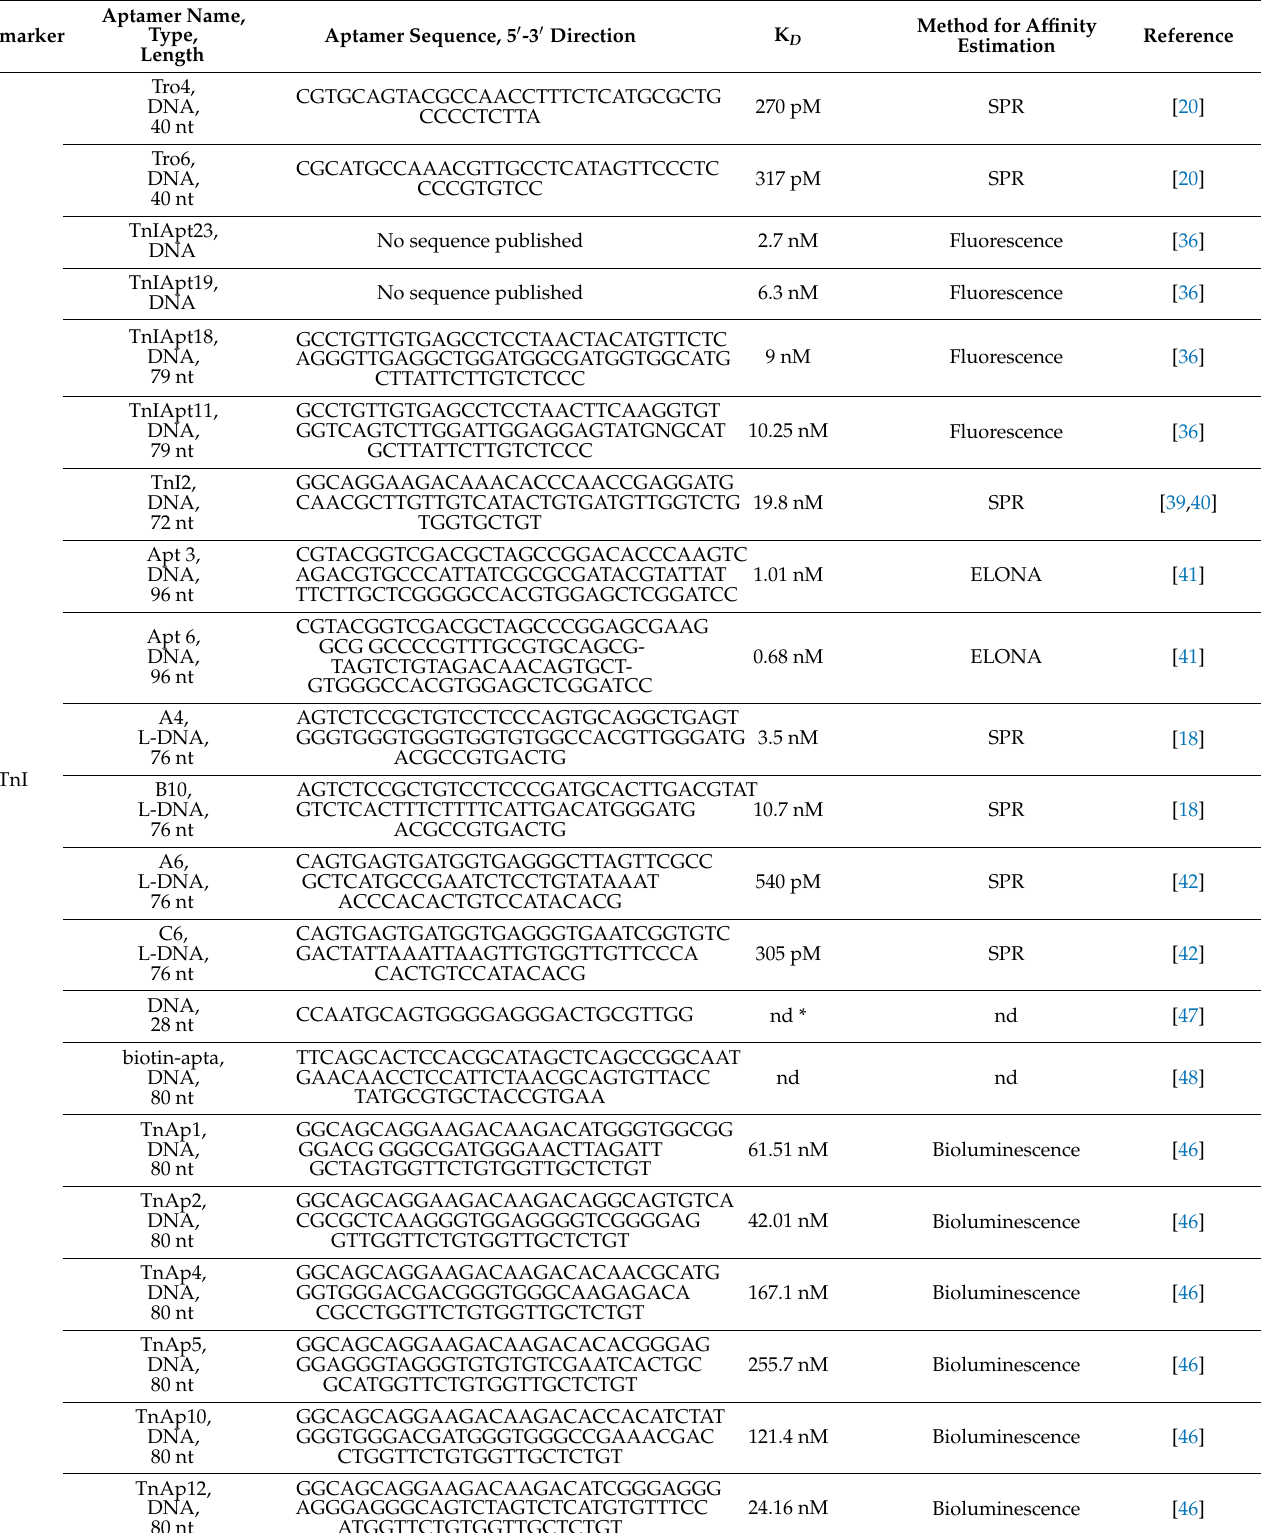
Table 1. Aptamers for cardiac